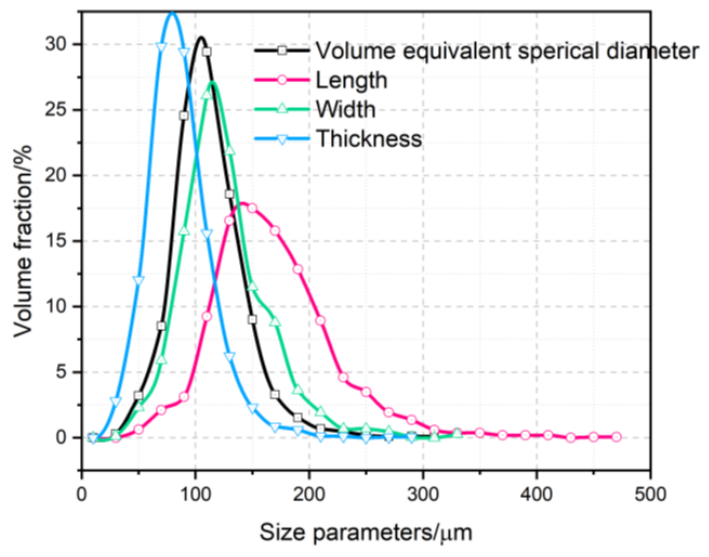
Figure 7. Comparison of the distribution of size parameters of L , W , T , and VESD for desert sand particles.